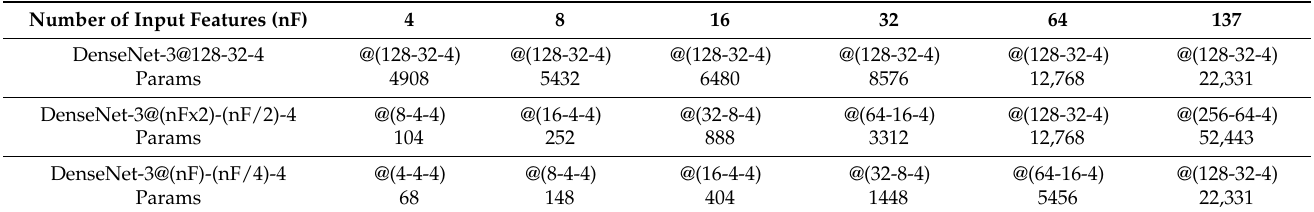
Table 5. Number of trainable parameters (Params) of different DenseNet-3 architectures, which are applied to the reduced feature set nF = 4, 8, 16, 32, 64 and the total 137 features.